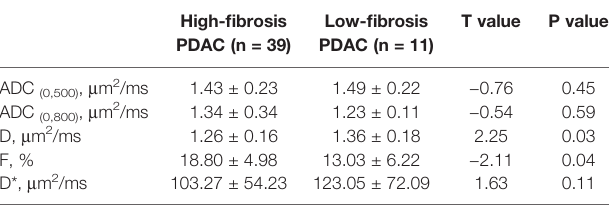
TABLE 2 | Comparison of DWI/IVIM Parameters Between High- and Low- Fibrosis